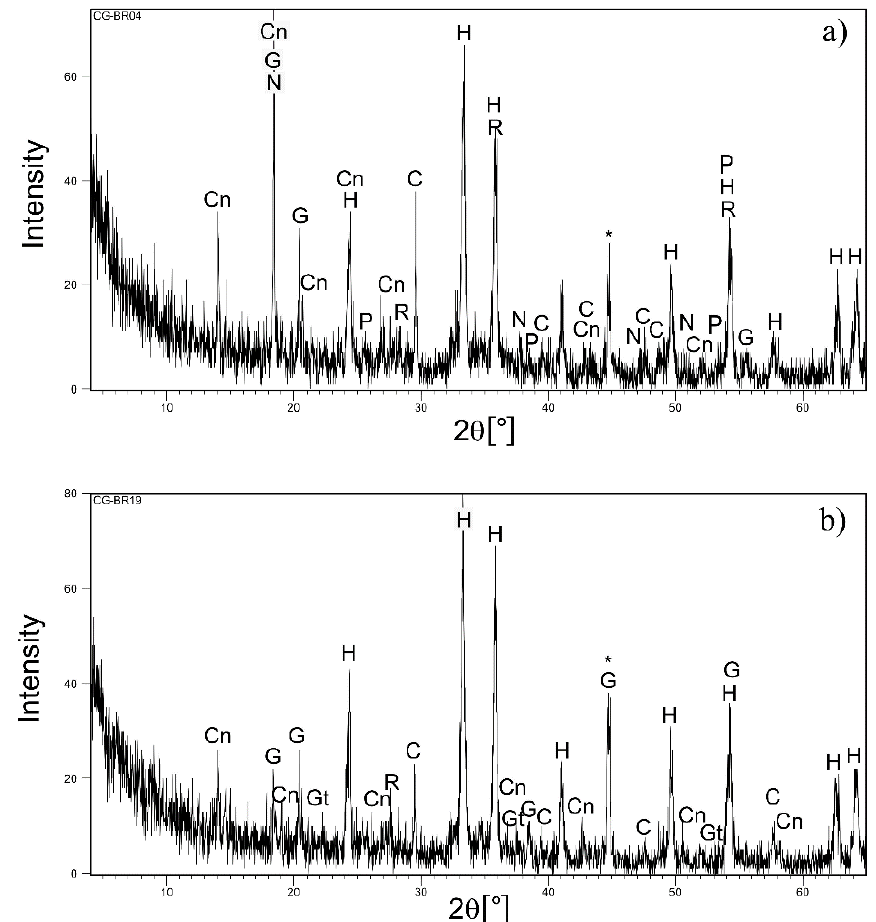
Figure 20. Mineral composition of the red mud samples from the KAP- Podgorica red mud landfill: Basin A ( a ), basin B ( b ). H—hematite, C—calcite, Cn—cancrinite, G—gibbsite, R—rutile, N—